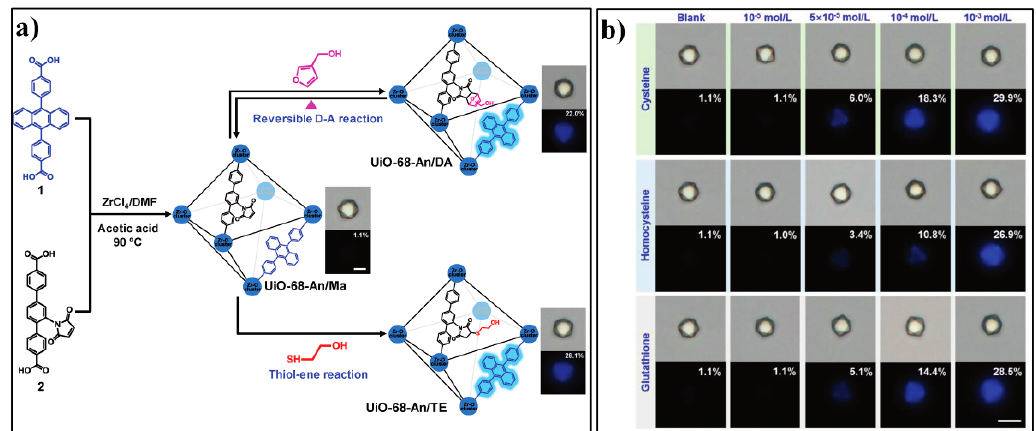
Figure 11. ( a ) Synthesis of UiO-68-An/Ma and tuning the fluorescent photoinduced electron transfer (PET) in the MOF through a reversible D–A reaction or thiol-ene reaction. ( b ) Bright-field and photoluminescence single-crystal images of UiO-68-An/Ma treated with different concentrations of Cys, Hcy, and GSH for 5 min. Reproduced with permission from [101]. Copyright Wiley-VCH, 2016. With the in-situ encapsulation of rhodamine B (RhB) into Cu-BTC, Gao and Huang et al.